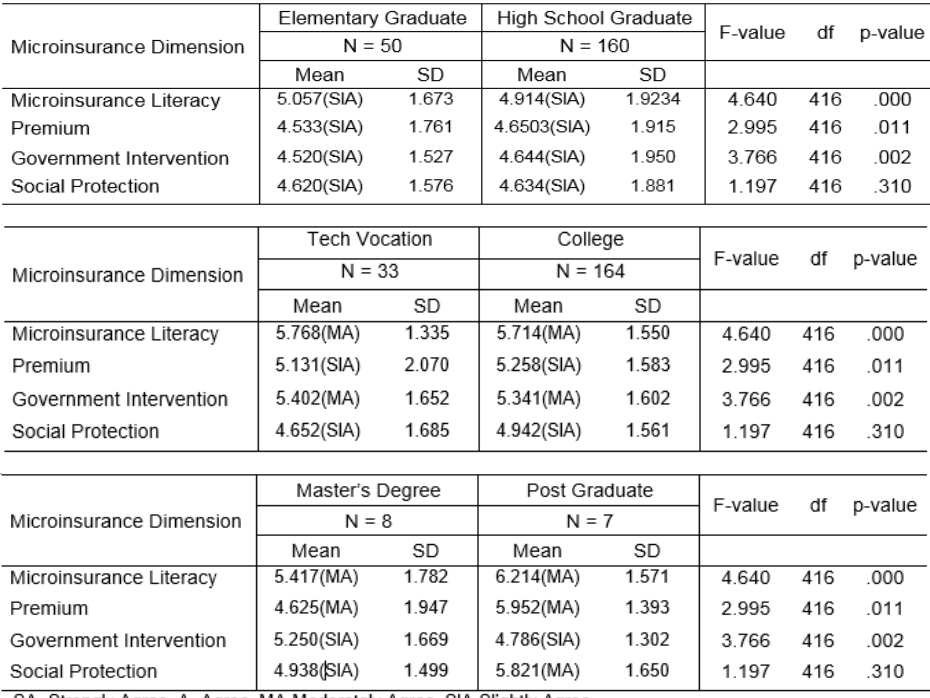
Table 9: Level of Agreement of the Respondents on the Dimensions of Microinsurance When Grouped According to Educational